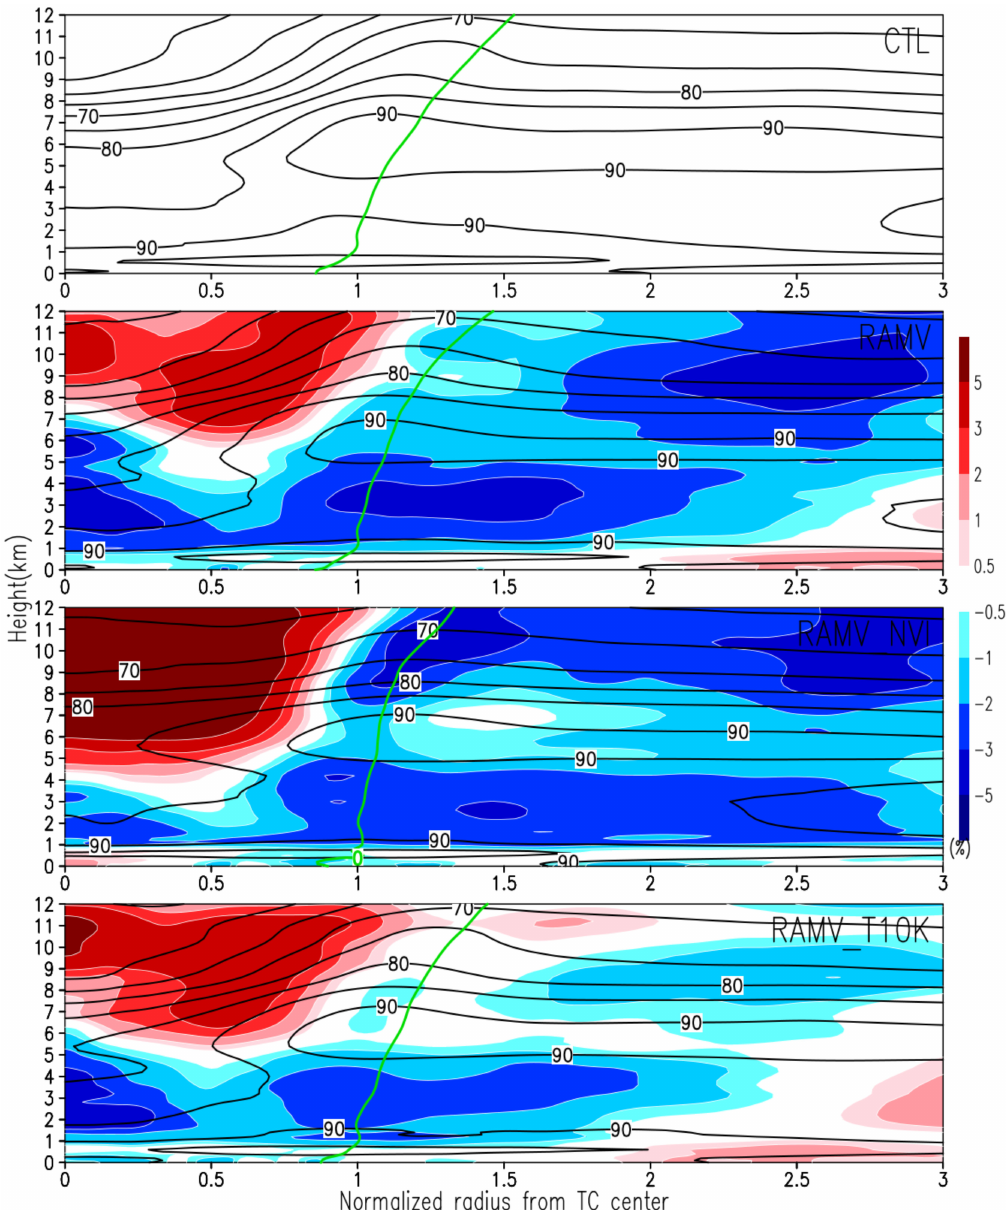
Figure 10. As in Figure 8, but for relative